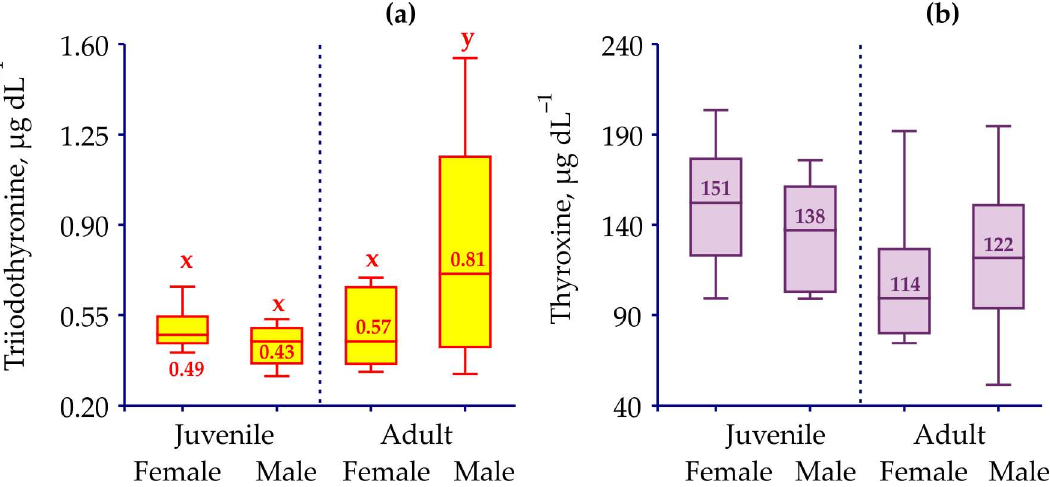
Figure 3. Variations in thyroid hormones in hemolymph of red king crabs (box plots) in relation to their sex and maturity status. Numbers indicate mean levels. Bars with the same letter are not significantly different ( p > 0.05). ( a ) Triiodothyronine, ( b ) thyroxine. The adult male and female concentrations did not differ significantly while the Table 2. Results of ANOVA or Kruskal–Wallis tests (KWT) comparing the differences in thyroid hormone levels of red king crabs from the Barents Sea. Hormone